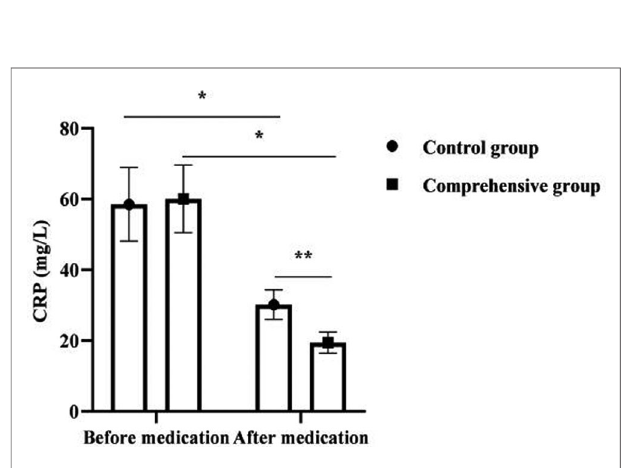
FIGURE 3 | Analysis of immune indexes in 120 children. Note: * was p < 0.05 for the comparison before and after medication; ** was p <0.05 for the comparison after medication.